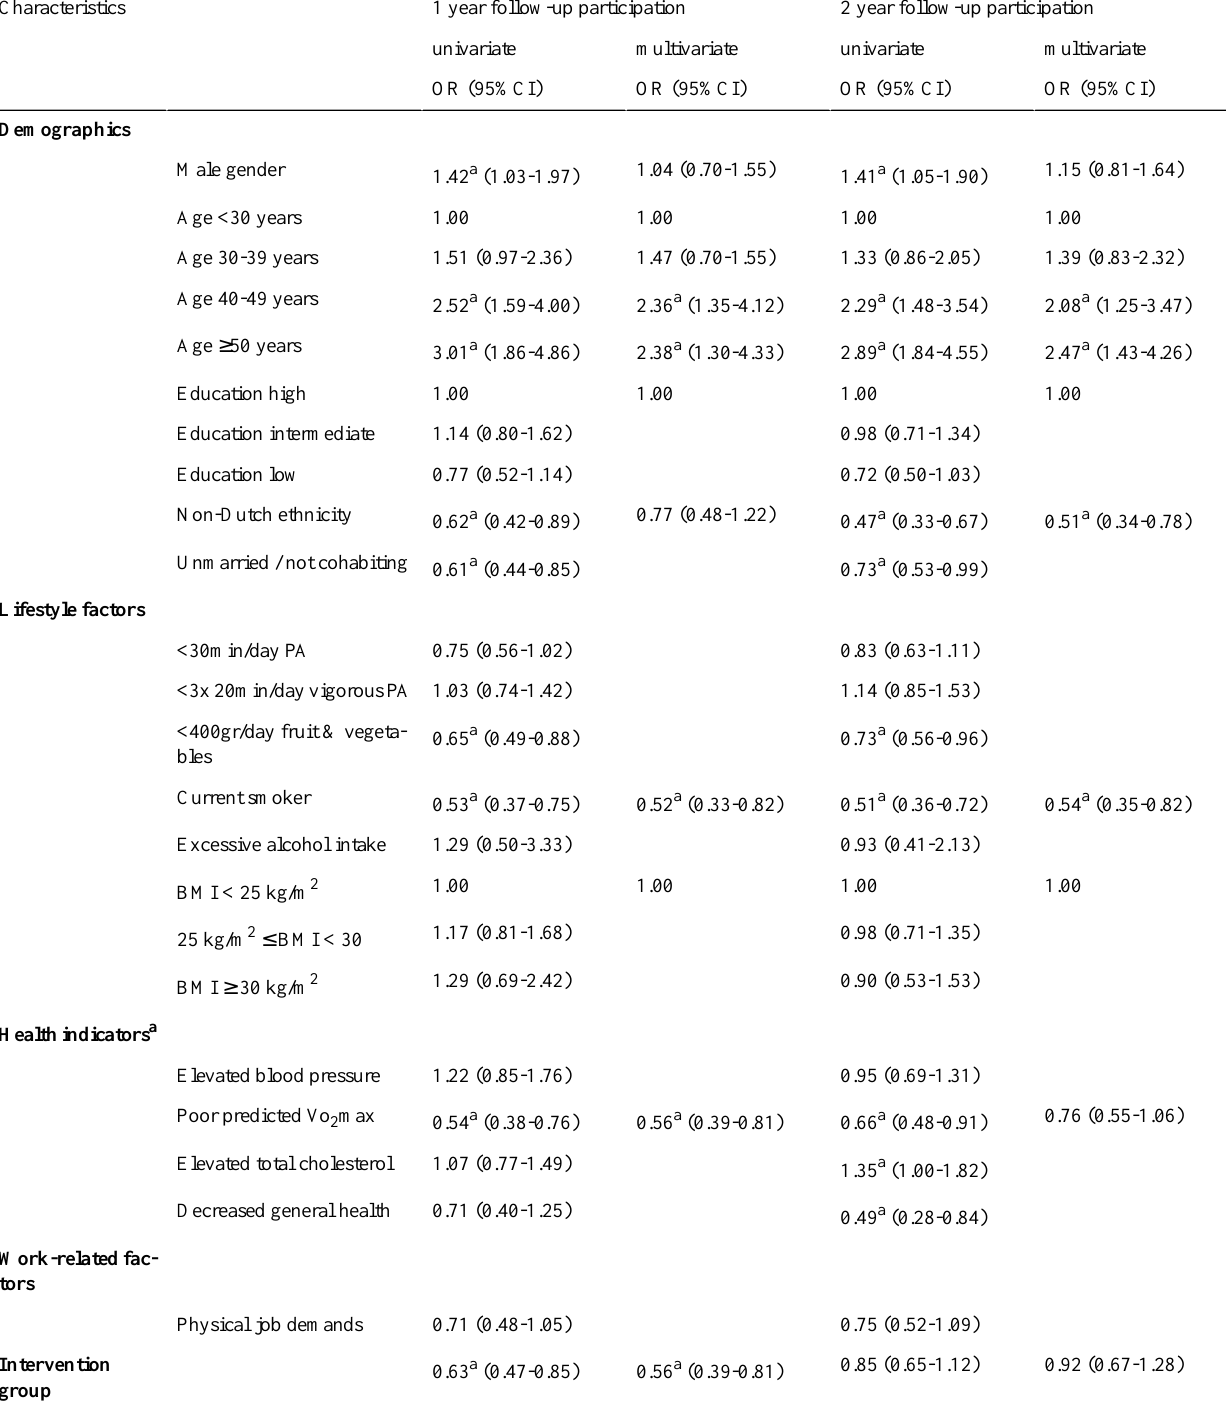
Table 2. Determinants of sustained participation after 1 and 2 years in a workplace health promotion program (n=924).